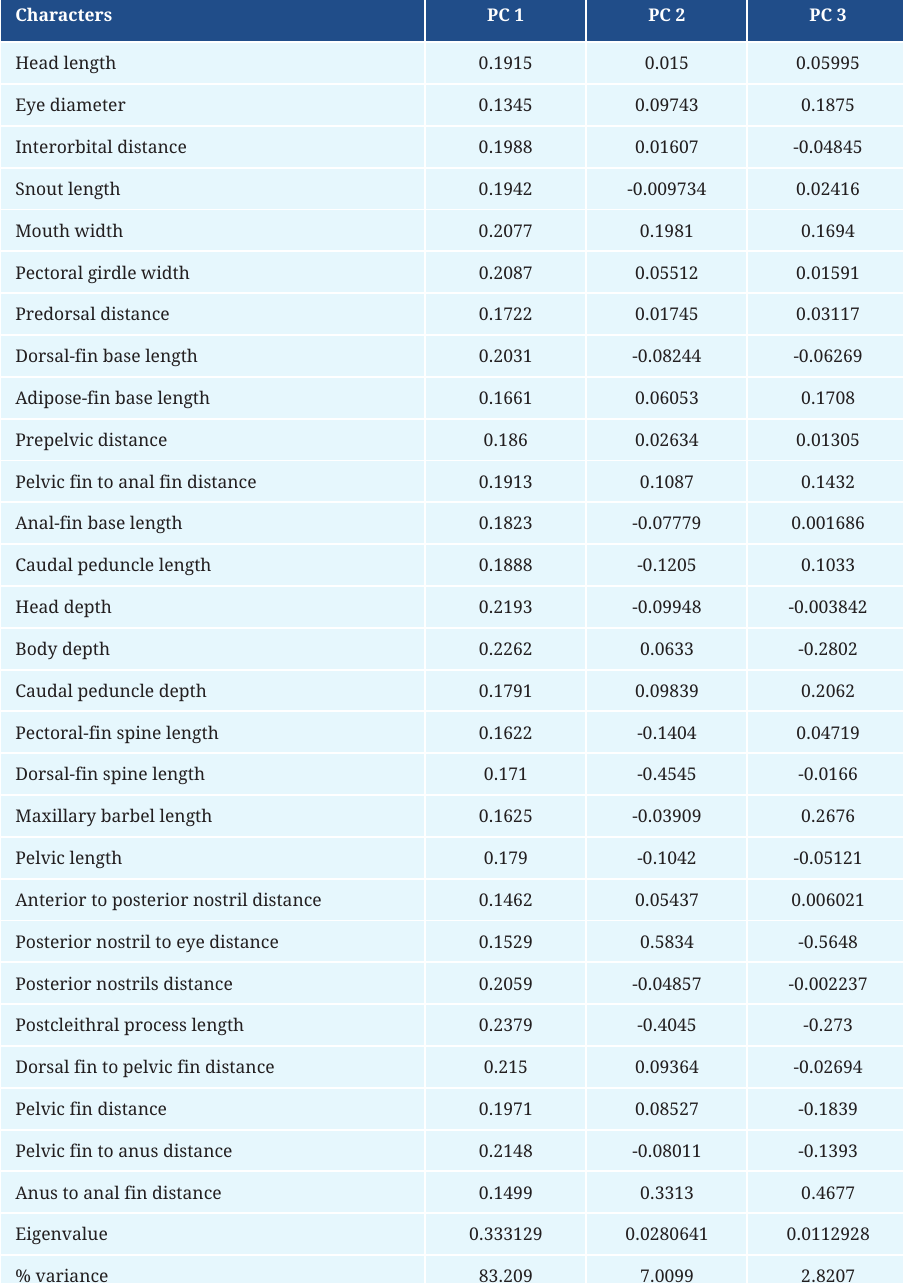
TABLE 2 | Character loadings of the first three principal components axes of combined analysis of Rhyacoglanis varii (N = 16), R. paranensis (N = 31), and R. rapppydanielae (N =